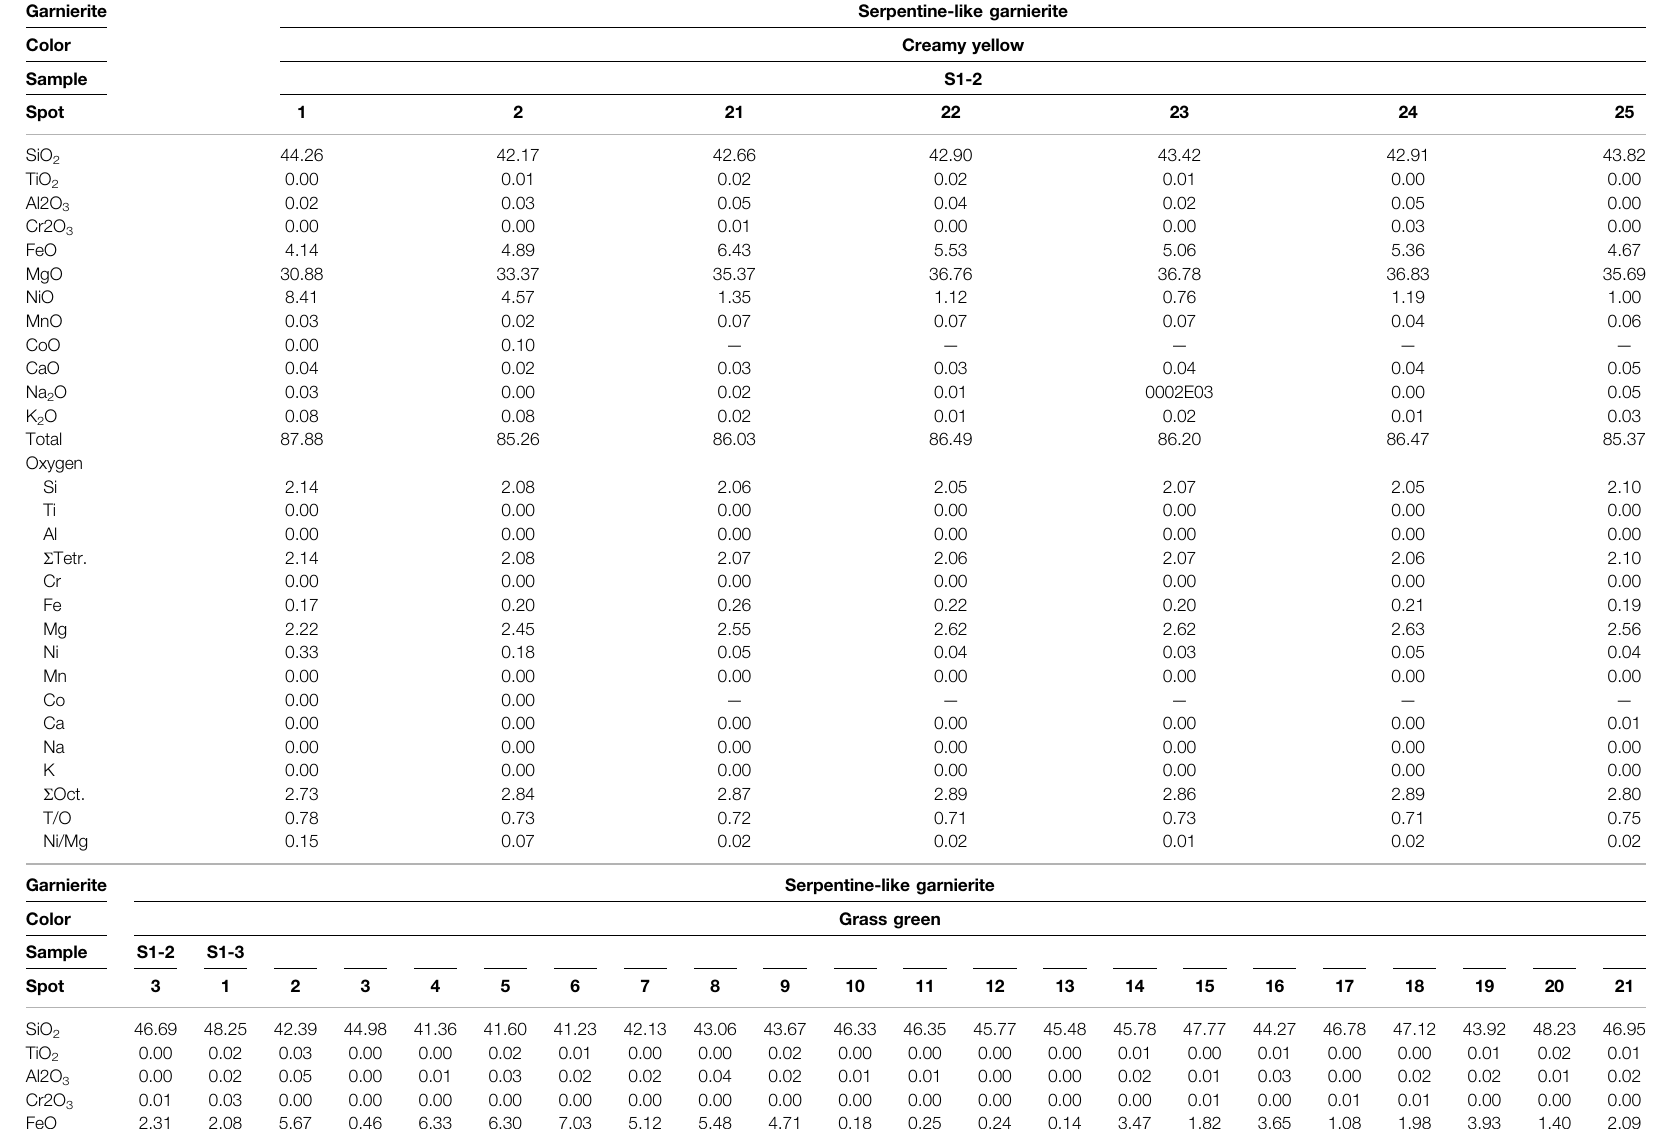
TABLE 2 | EPMA data of serpentine- and talc-like garnierites (in wt%). Garnierite Serpentine-like garnierite Color Creamy yellow